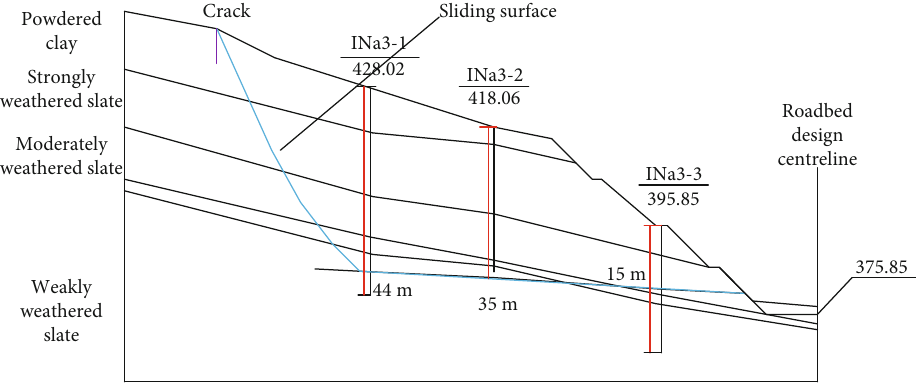
Figure 6: Engineering geological pro fi le a3-a3 ′